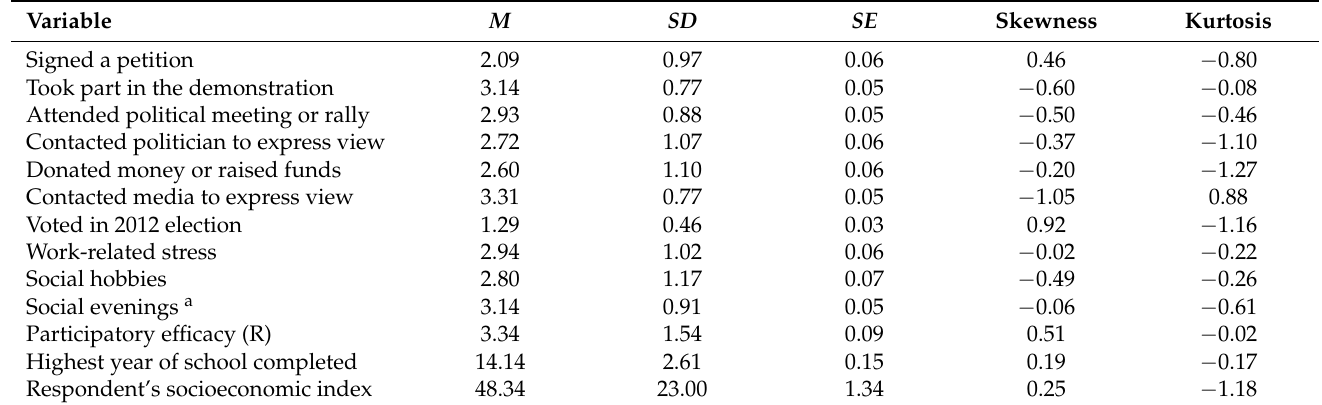
Table 1. Descriptive Statistics ( n = 295).